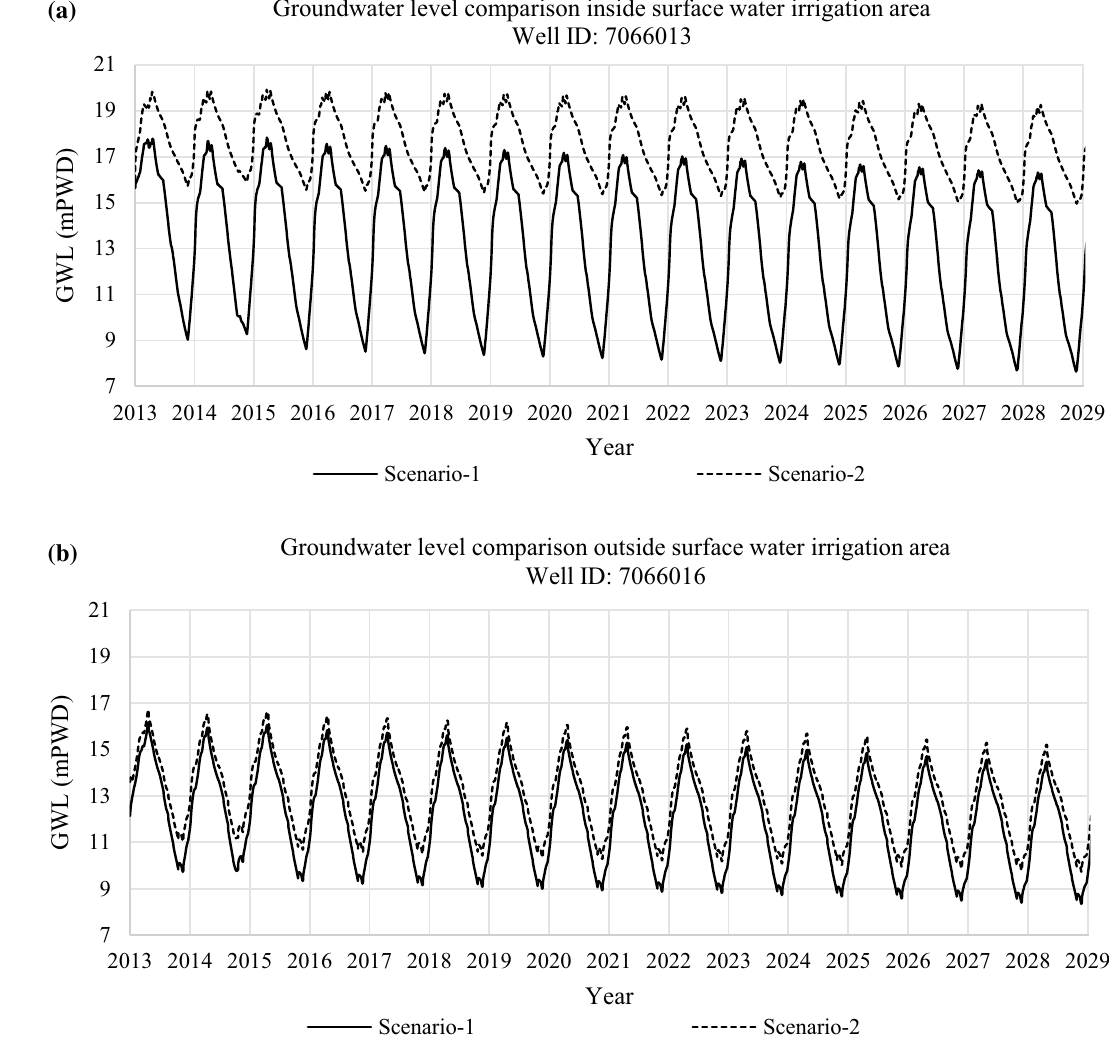
Fig. 12 Long-term simulation of well a GT7066013 and b GT7066016. The groundwater level decreasing rate is 50 mm/year for GT7066013 for scenario-2. In contrast, the groundwater